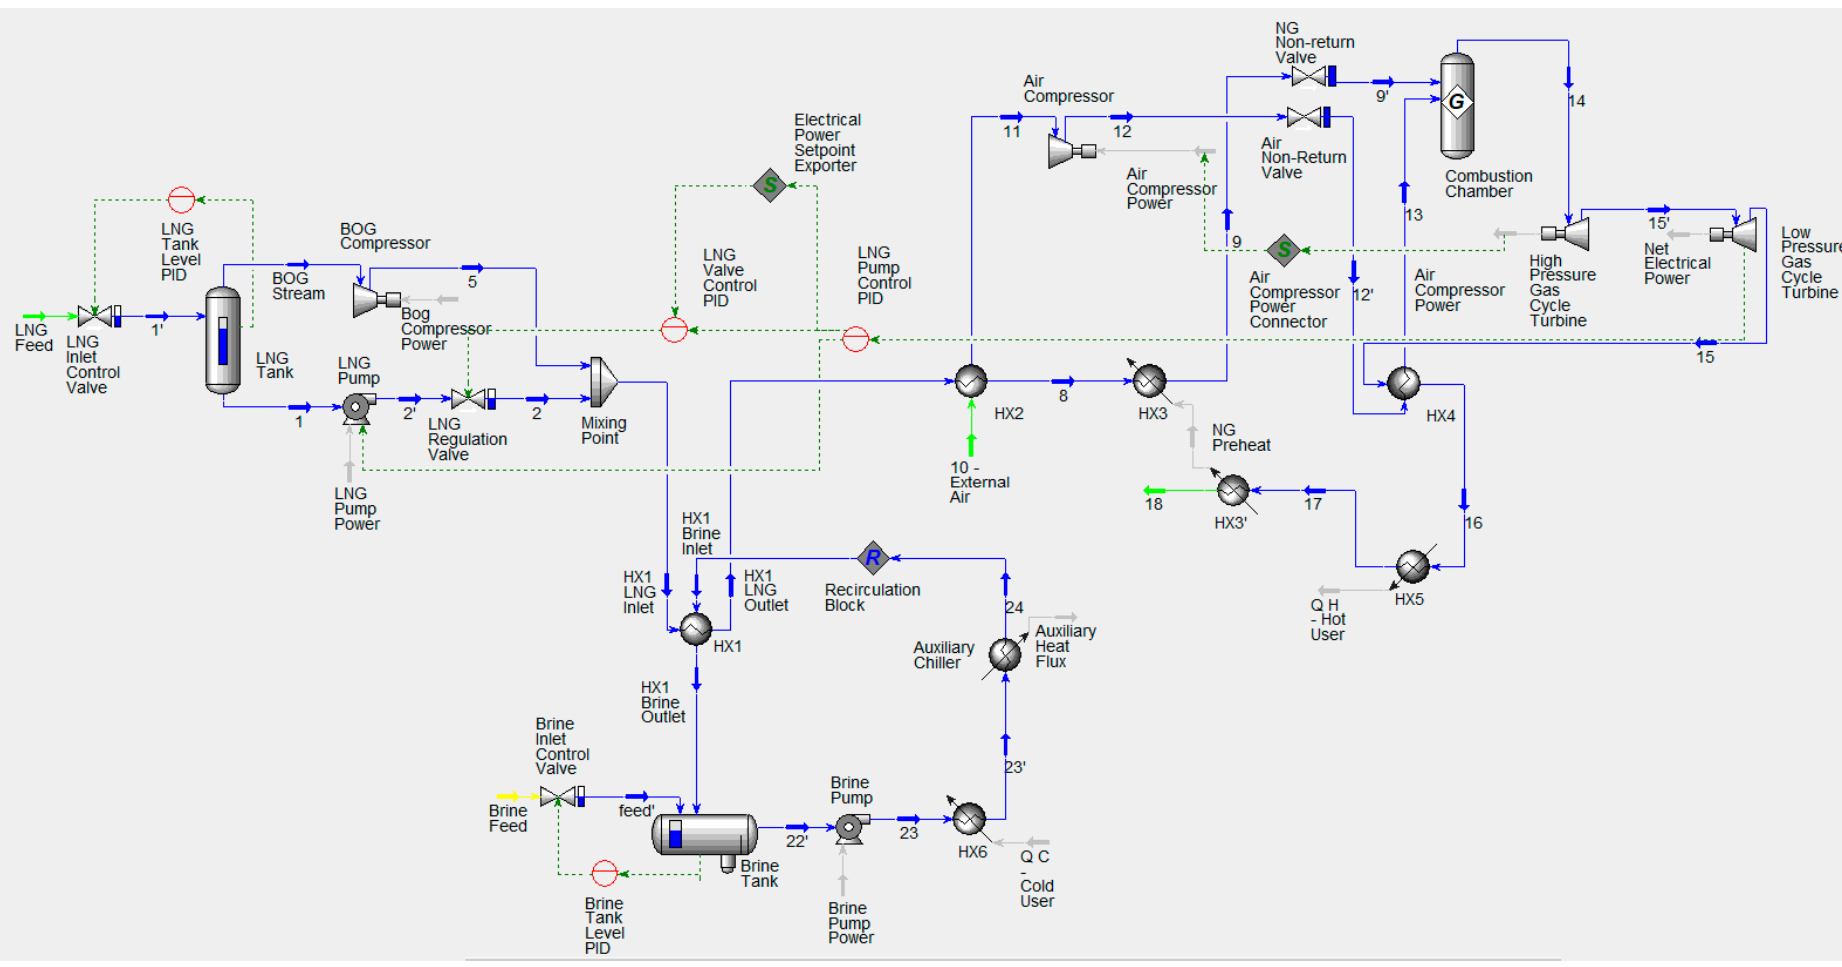
Figure 1. LNG combined system layout . 2